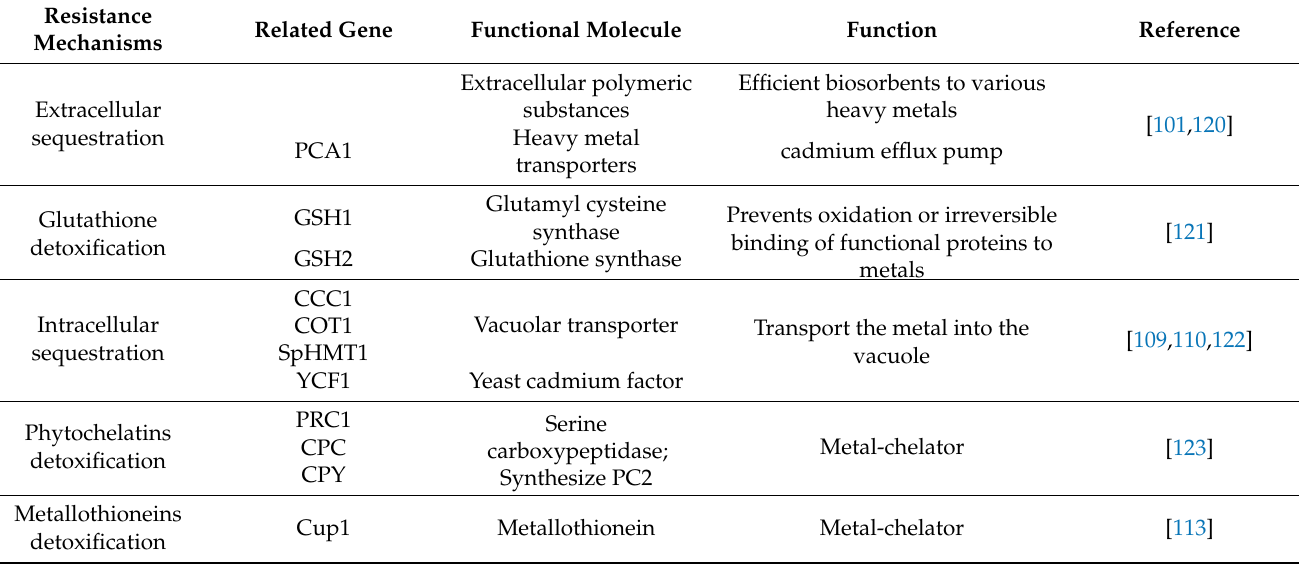
Figure 1. Model for transport and detoxification mechanism of metal trace elements by yeast. Table 2. Resistance mechanisms of yeast towards heavy metal ions.